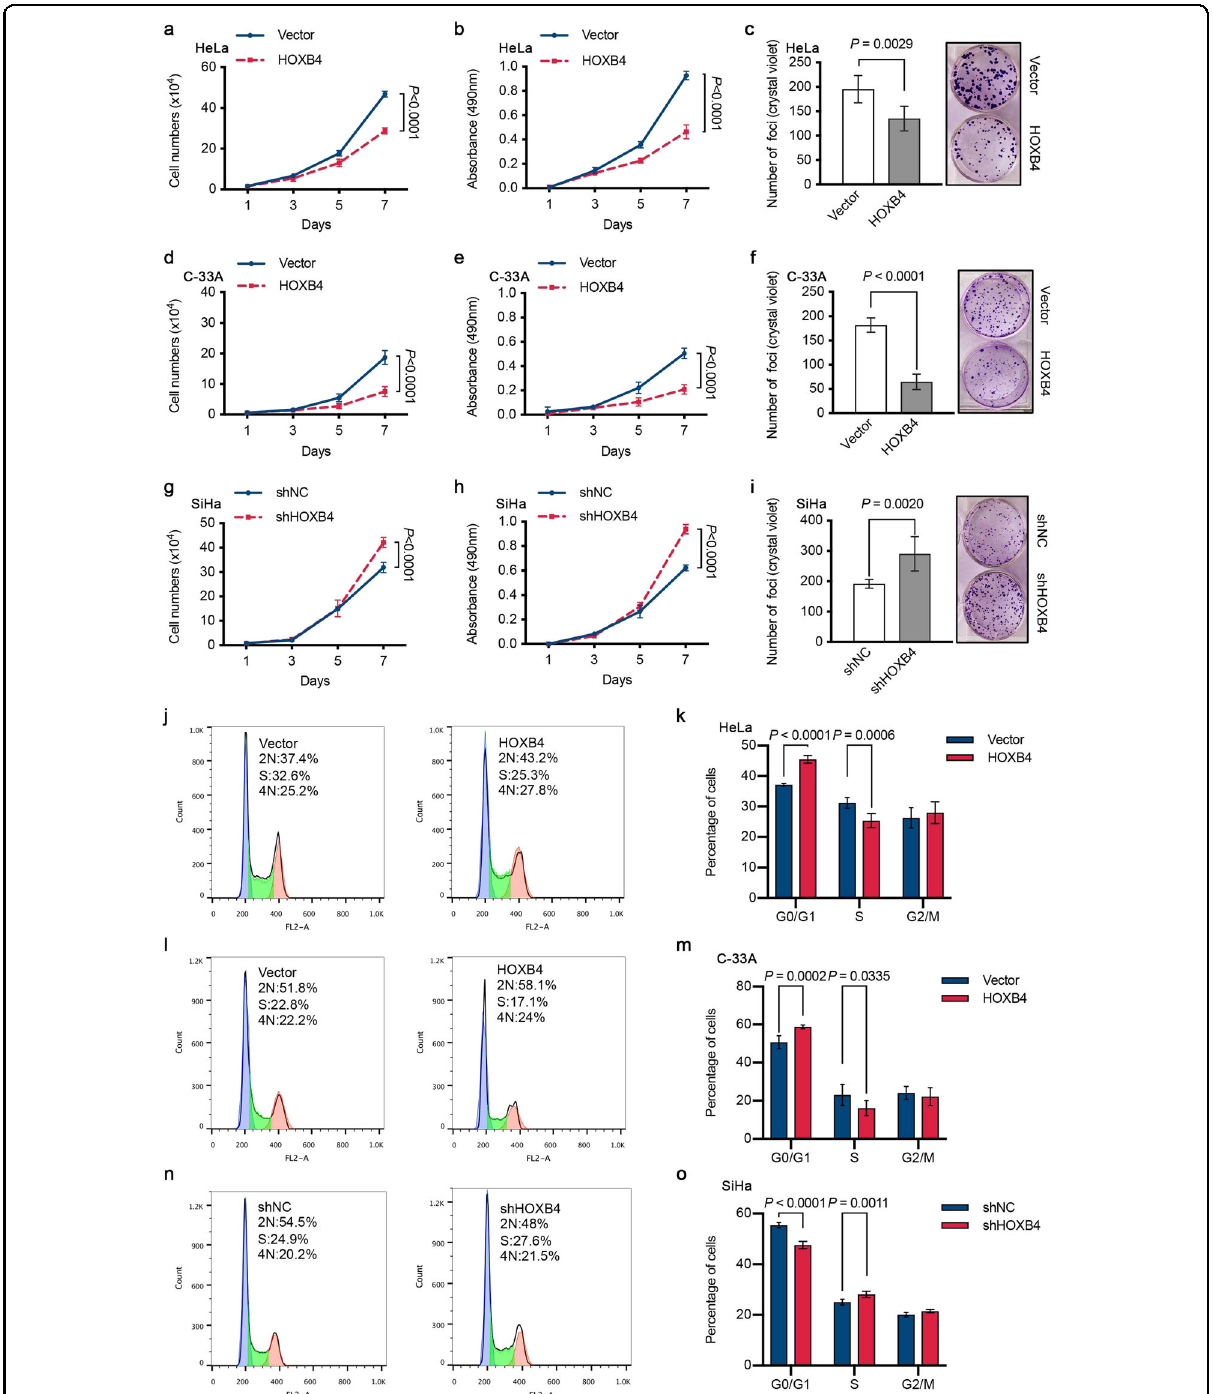
Fig. 3 HOXB4 inhibited cell proliferation and arrested the cell cycle in vitro. a – i Inhibition of cell proliferation by HOXB4. Cell counting ( a ), MTT ( b ), and colony formation ( c ) assays were performed in HOXB4-overexpressing HeLa cells and control cells. Representative images of the colony formation assay with crystal violet staining ( c , right) were shown, and colonies were quanti fi ed by counting ( c , left). These proliferation experiments (cell counting, MTT, and colony formation assays) were also performed in HOXB4-overexpressing C-33A cells ( d – f ) and HOXB4-depleted SiHa cells ( g – i ). j – o Cell cycle distribution in modi fi ed transfected cervical cancer cell lines. Cell cycle pro fi les were obtained by FACS analysis of propidium iodide- stained cells and analyzed by fl ow cytometry in HOXB4-overexpressing HeLa ( j , k ) and C-33A ( l , m ) cells, as well as in HOXB4-depleted SiHa ( n , o )